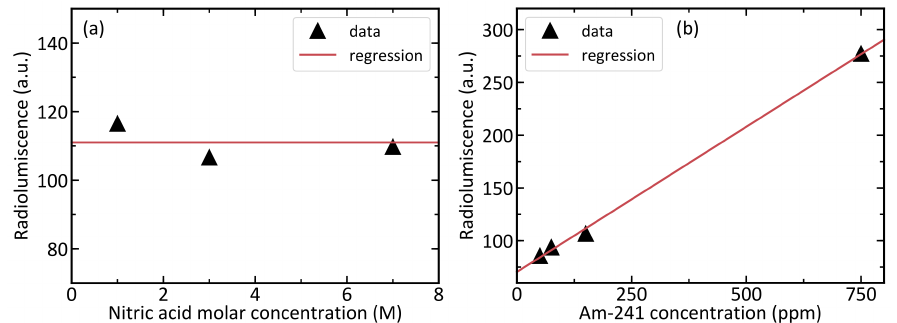
Figure 6. Dependence of the measured radioluminescence intensity on the nitric acid concentration and the americium concentration. The pixel values displayed as radioluminescence have been corrected for the image background. ( a ) Change of the radioluminescence with a varying nitric acid concentration. A constant has been fitted to the data. ( b ) Change of the radioluminescence with varying Am-241 concentration. A linear function has been fitted to the data.